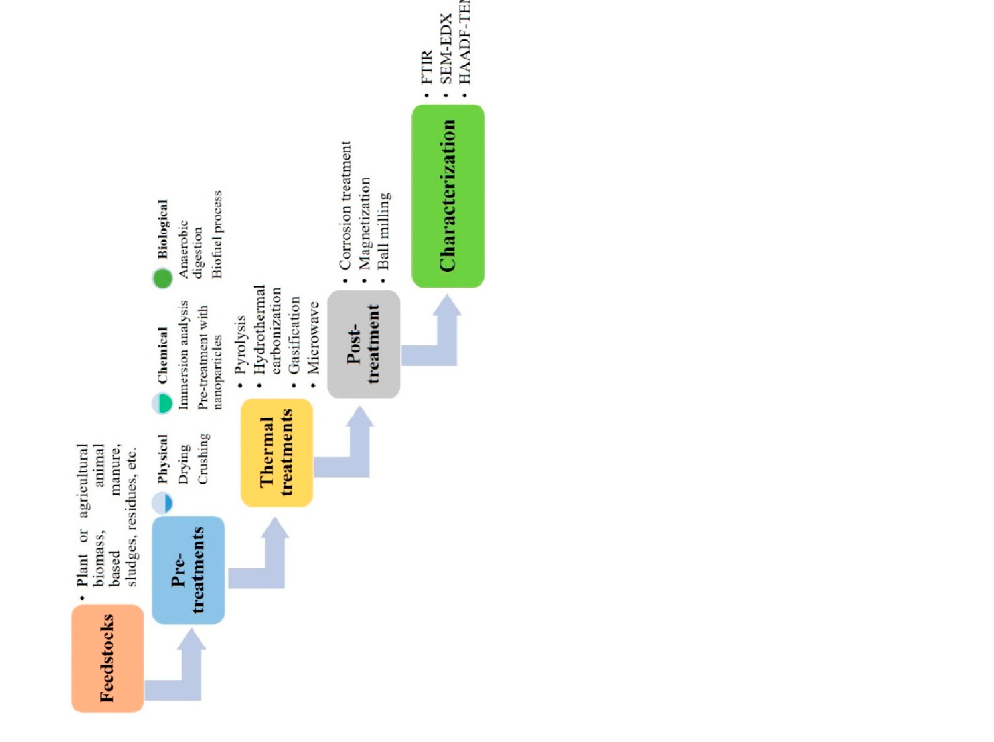
Figure 1. Representative workflow of the technologies/methodologies used for the production of